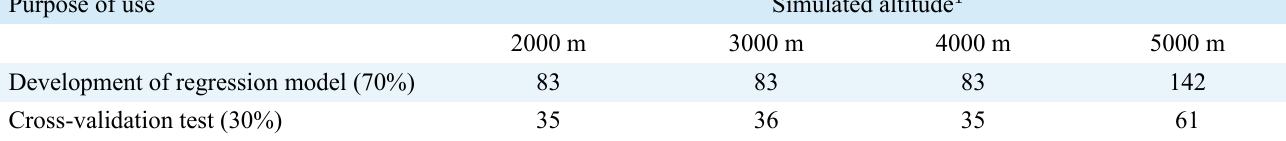
TABLE 4. Sample size after applying Bernoulli’s trials